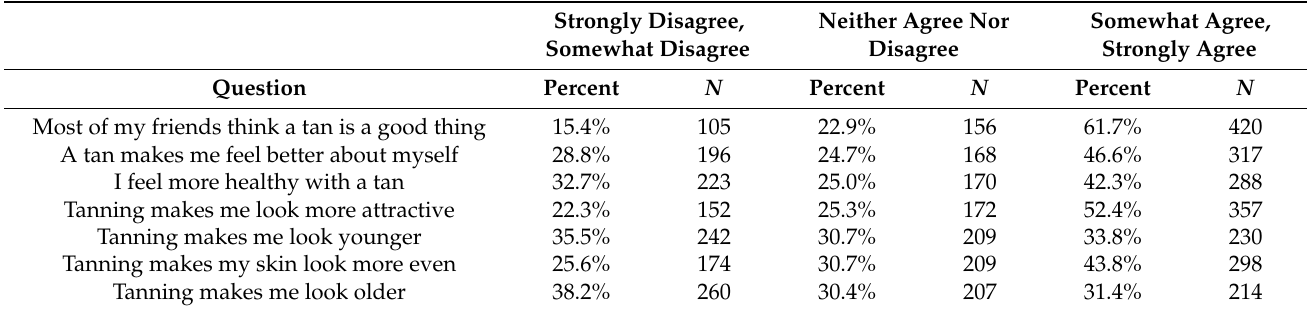
Table 3. Men’s perceptions toward tanning ( n = 705).